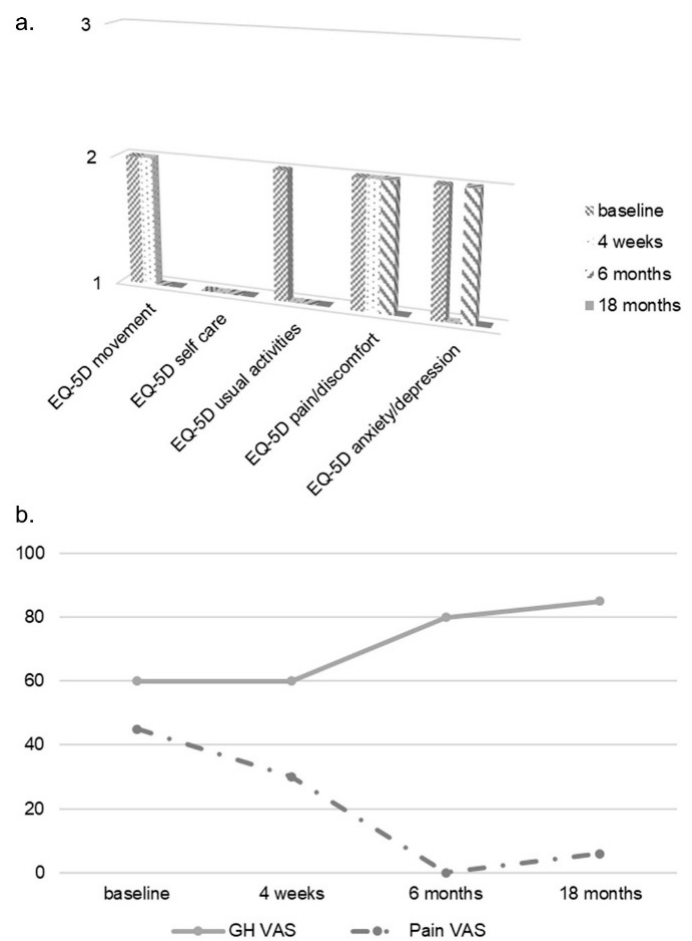
Figure 4. Health-related quality of life of the patient. The figure shows the results for each domain of EQ-5D ( a ), general health (GH) visual analogue scale (VAS) and pain VAS reported by the patient at baseline and during follow-up ( b ).